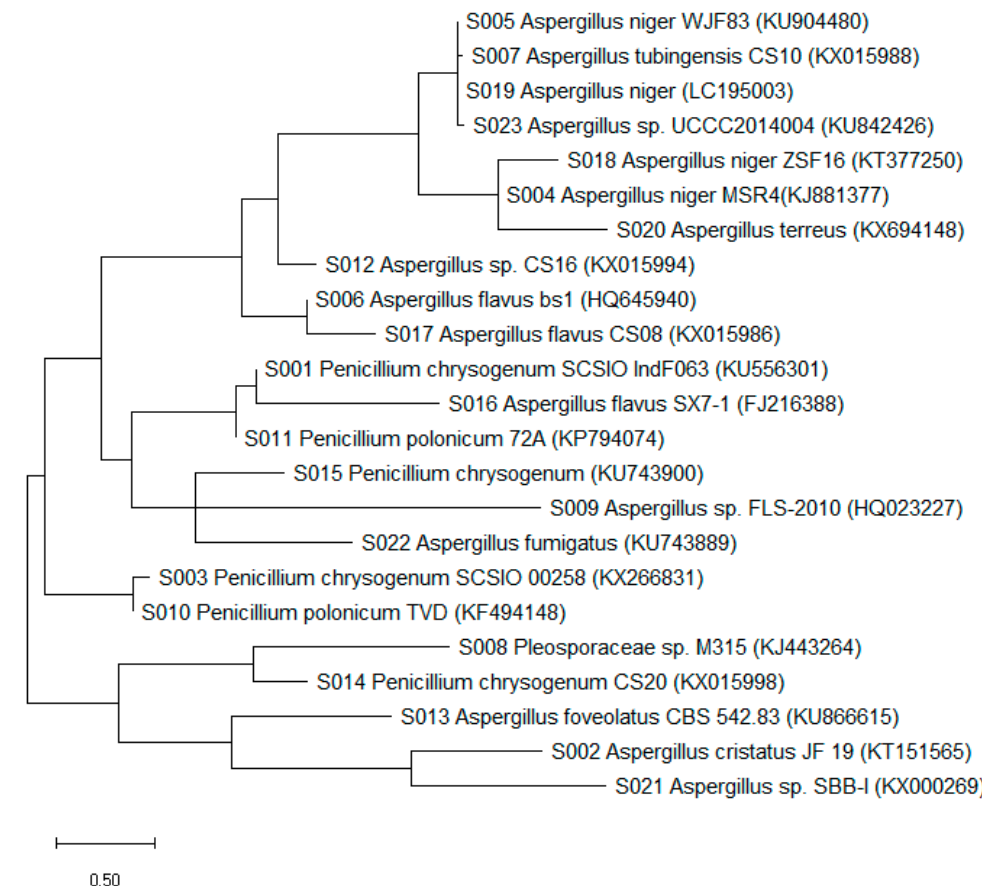
Figure 2. Phylogenetic tree of isolated fungal strains S001–S023.